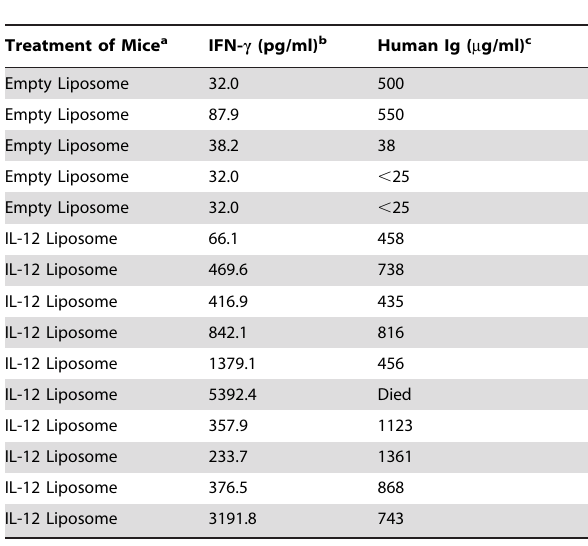
Table 2. Evidence of Viability and Function of T Cells and Plasma Cells in Tumor Bearing Mice.